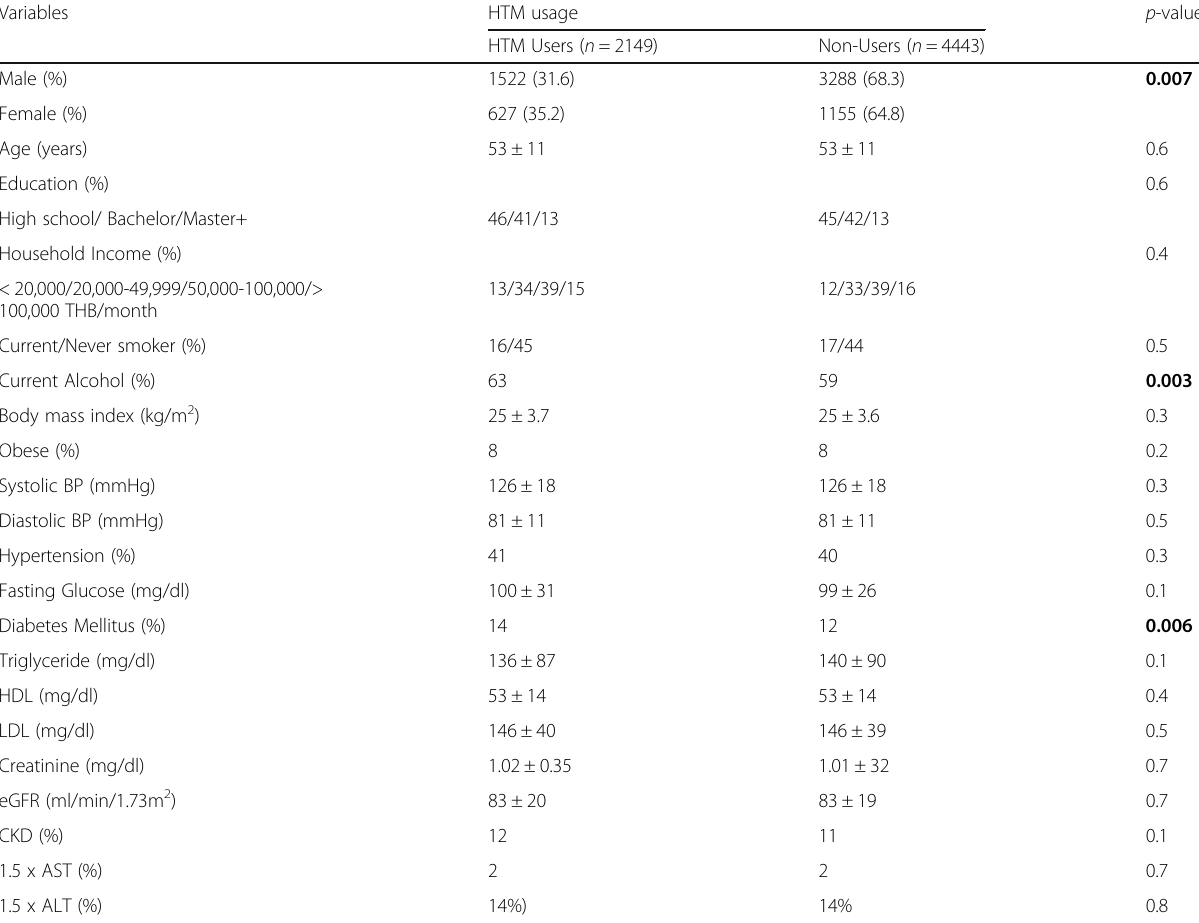
Table 1 Demographic and laboratory characteristics according to HTM use Variables HTM